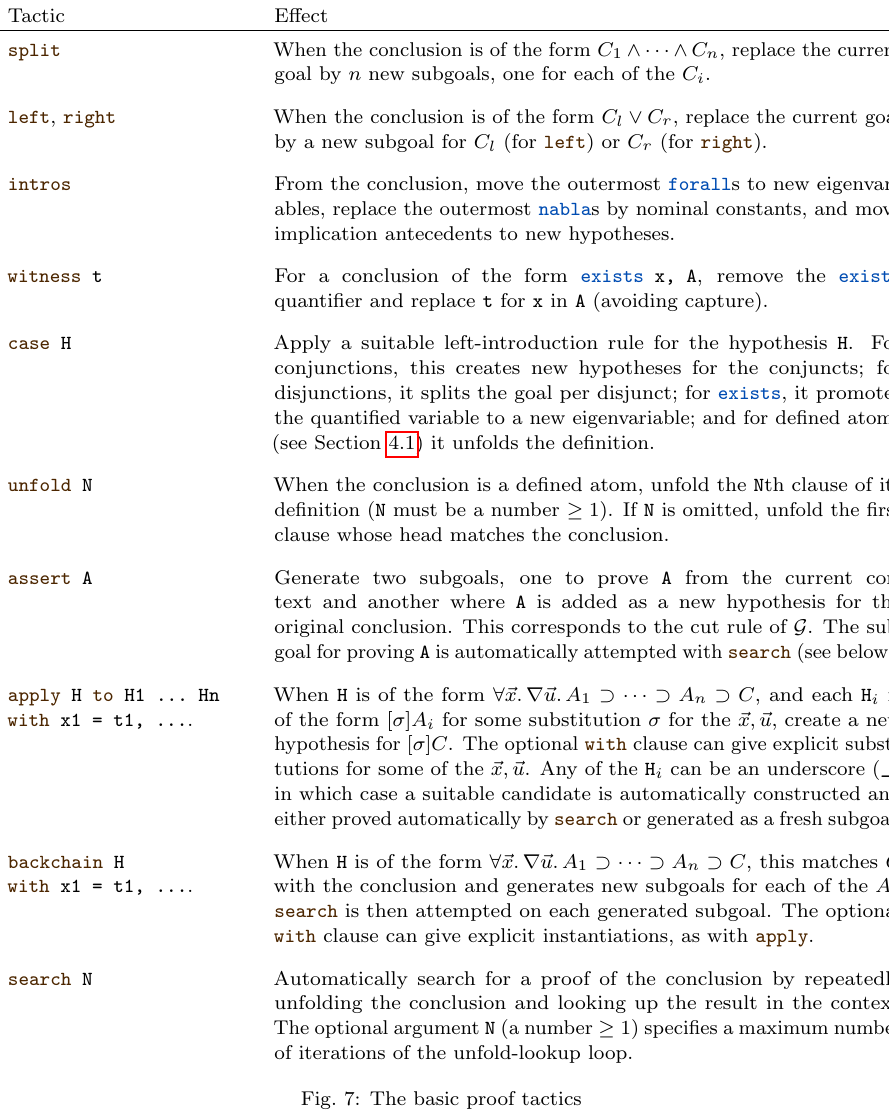
Fig. 7: The basic proof